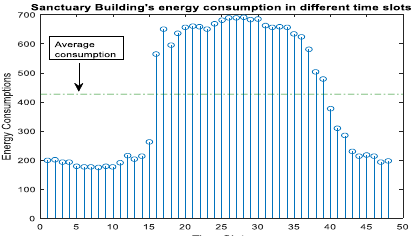
Figure 4. Energy load distribution in Sanctuary building (sample)